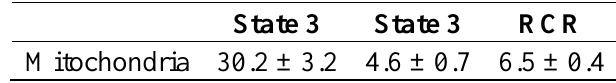
1. Mitochondria isolation from R . microplus embryos on the 9th day of embryogenesis. State 3 State 3 RCR Mitochondria 30.2 ± 3.2 4.6 ± 0.7 6.5 ±